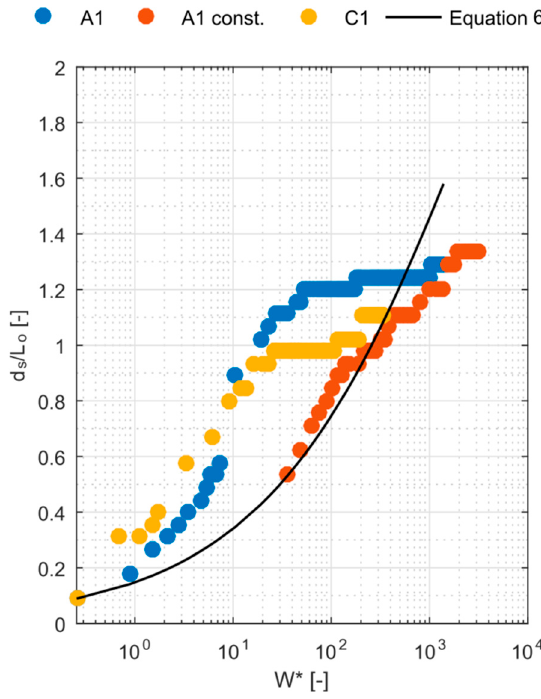
Figure 9. Dimensionless scour hole depth (d s /L o ) versus dimensionless flow work (W*) observed in symmetrical hydrographs of different durations in clear-water conditions.